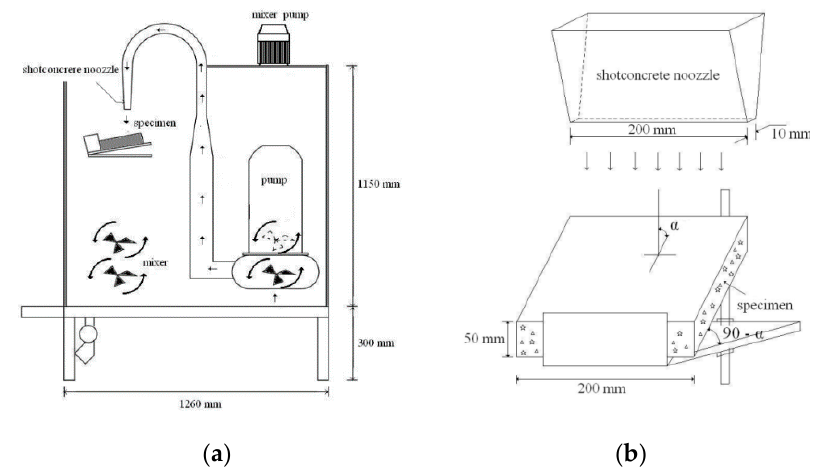
Figure 2. ( a ) Test apparatus for waterborne sand flow impact abrasion, ( b ) Schematic diagram of nozzle.